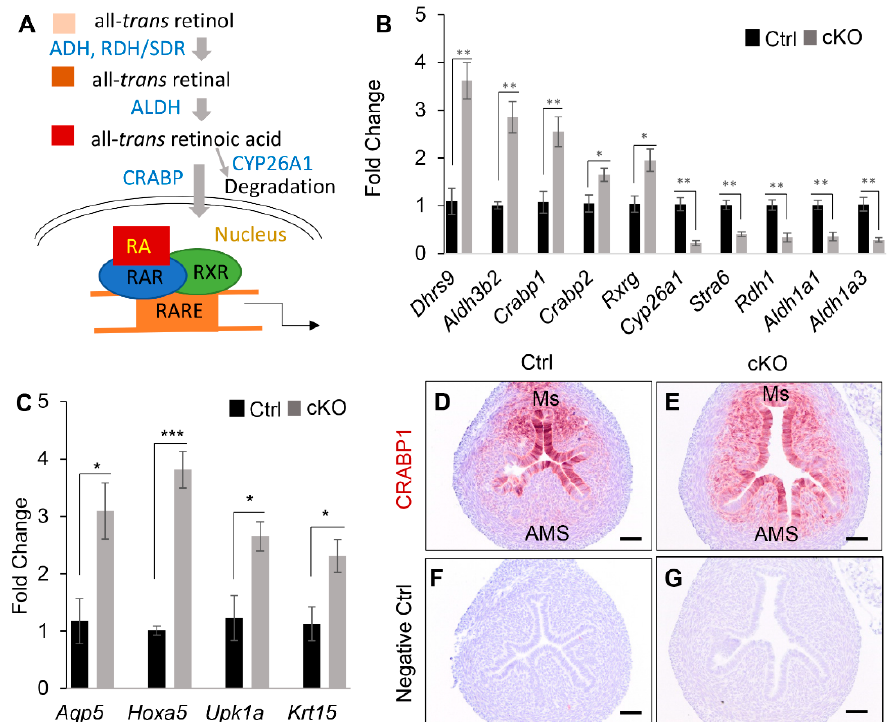
Figure 5. Dysregulation of RA signaling in the uteri of Ezh2 Amhr2 ‐ Cre cKO mice at PD10. ( A ) Sche ‐ matic representation of RA signaling. All ‐ trans retinol is oxidized by ADH or RDH/SDR to all ‐ trans retinal, which is further oxidized to all ‐ trans RA via ALDH. RA can be transported to the nucleus by CRABP and induce signaling events via interacting with its nuclear receptors. RA can also be degraded by CYP26A1. ( B , C ) qRT ‐ PCR analysis of RA signaling ‐ associated genes using uteri from control and Ezh2 Amhr2 ‐ Cre cKO mice at PD10. n = 4. Data are mean ± s.e.m. * p < 0.05, ** p < 0.01, and *** p < 0.001. ( D – G ) Immunostaining of CRABP1 in the uteri of Ezh2 Amhr2 ‐ Cre cKO mice and controls at PD10. At least three animals for each genotype were examined. Scale bar = 50 µ m ( D – G